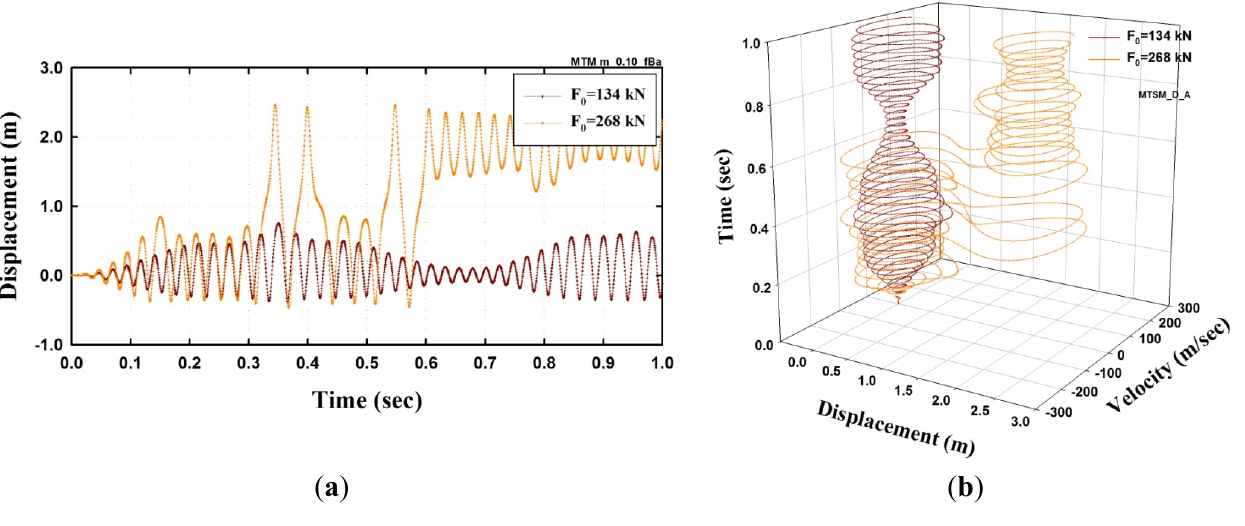
Figure 8. Dynamic analysis results of SFN model under a beating excitation ( μ (cid:3404) 0.1, α (cid:3404) 1.0, β (cid:3404) 0.1 ). ( a ) Displacement; ( b ) Trajectory in the phase space.